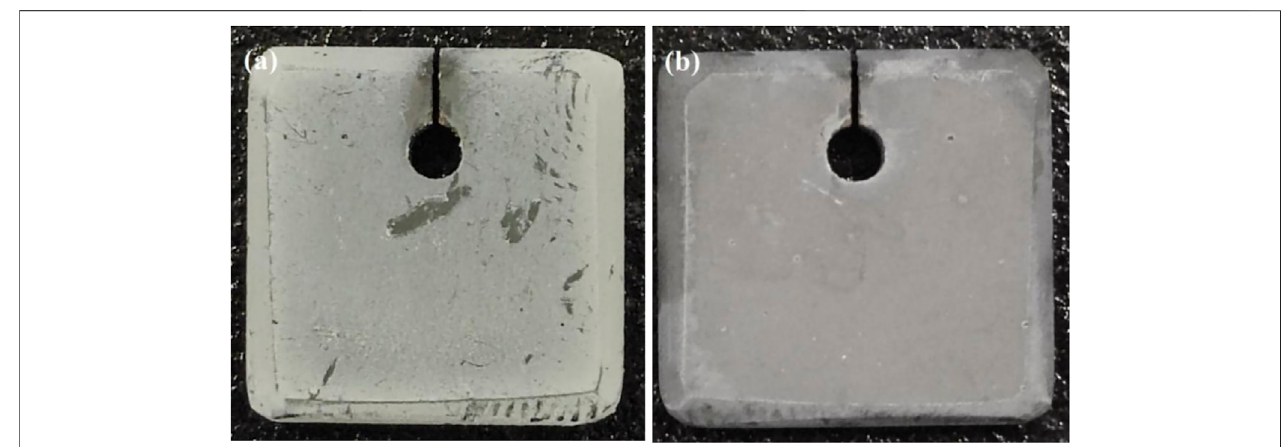
FIGURE 3 | Surface with (A) alumina particles after oxidation and (B) removal of alumina particles after oxidation.